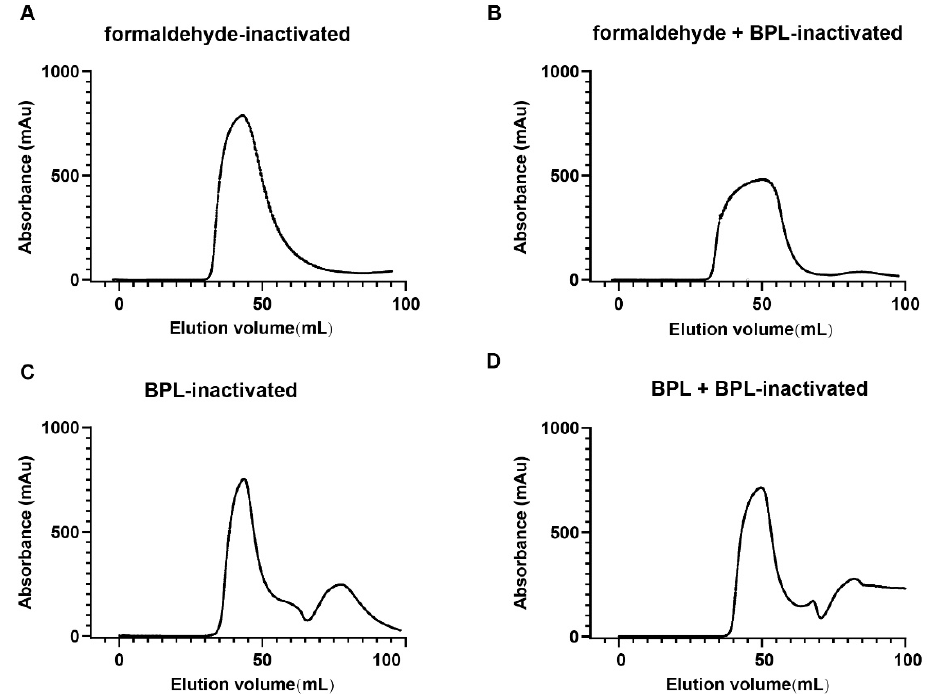
Figure 1. Size exclusion chromatography results of different inactivated virus samples ( A – D ). Size exclusion chromatography (SEC) results of viral supernatant inactivated with four different chemical inactivation methods ( A ) Formaldehyde-inactivated. ( B ) Formaldehyde + BPL-inactivated. ( C ) BPL-inactivated. ( D ) BPL + BPL ‐ inactivated.